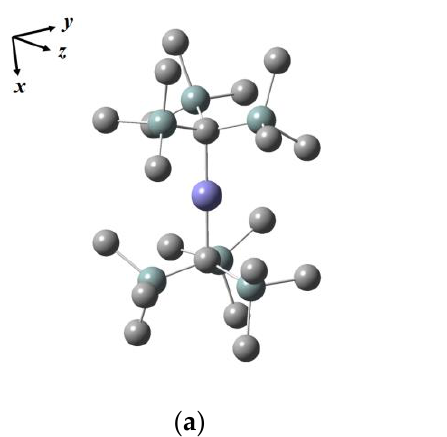
Figure 3. ( a ) Crystal structure of the [Fe(C(SiMe 3 ) 3 ) 2 ] − anion. Fe, purple; C, gray; Si, cyan. For clarity, all hydrogen atoms are omitted. ( b ) Calculated 3 d orbital energy for [Fe(C(SiMe 3 ) 3 ) 2 ] − . Normally, Fe(III) ion with half-filled 3 d orbitals ( S = 5/2) is not thought to be a suitable choice for composing SMMs with high U eff as a result of the less orbital degeneracy of